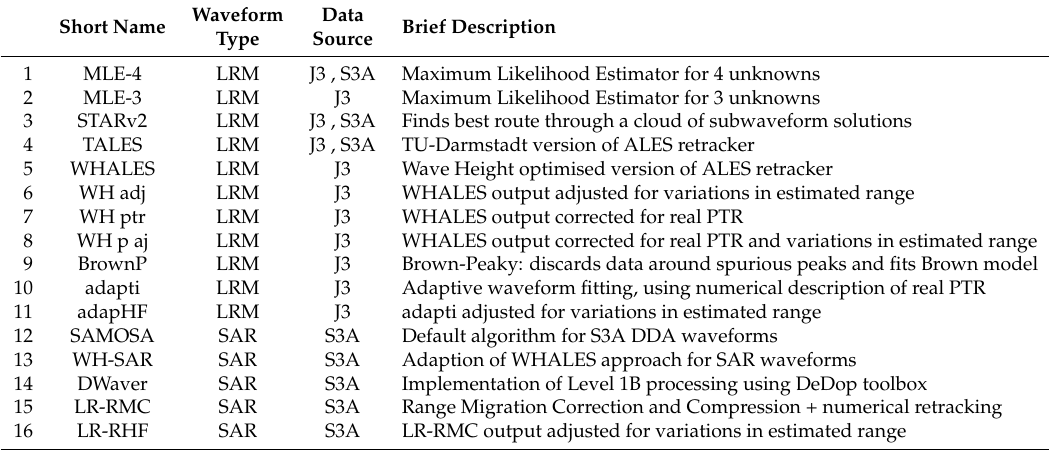
Table 1. Summary of the different retrackers investigated. Retracker 3 selects a smooth profile, and retrackers 6, 8, 11, & 16 include smoothed corrections applied to 5, 7, 10, & 15, respectively, and they are indicated by round plot symbols in some subsequent